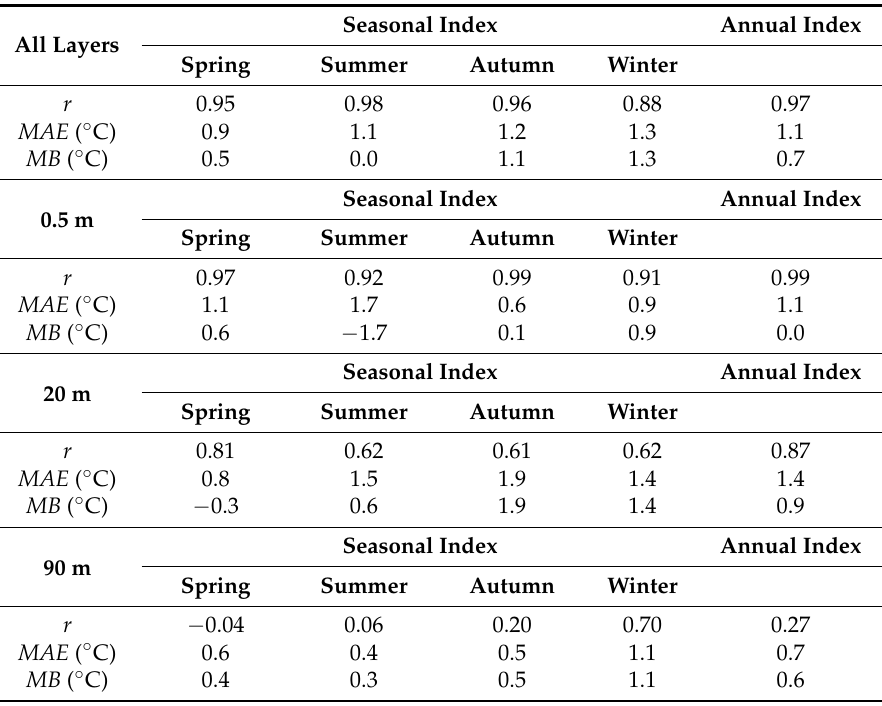
Table 1. Statistical indicators between the observed and simulated data (mean values for 5 years). MAE : mean absolute error; MB : mean bias.